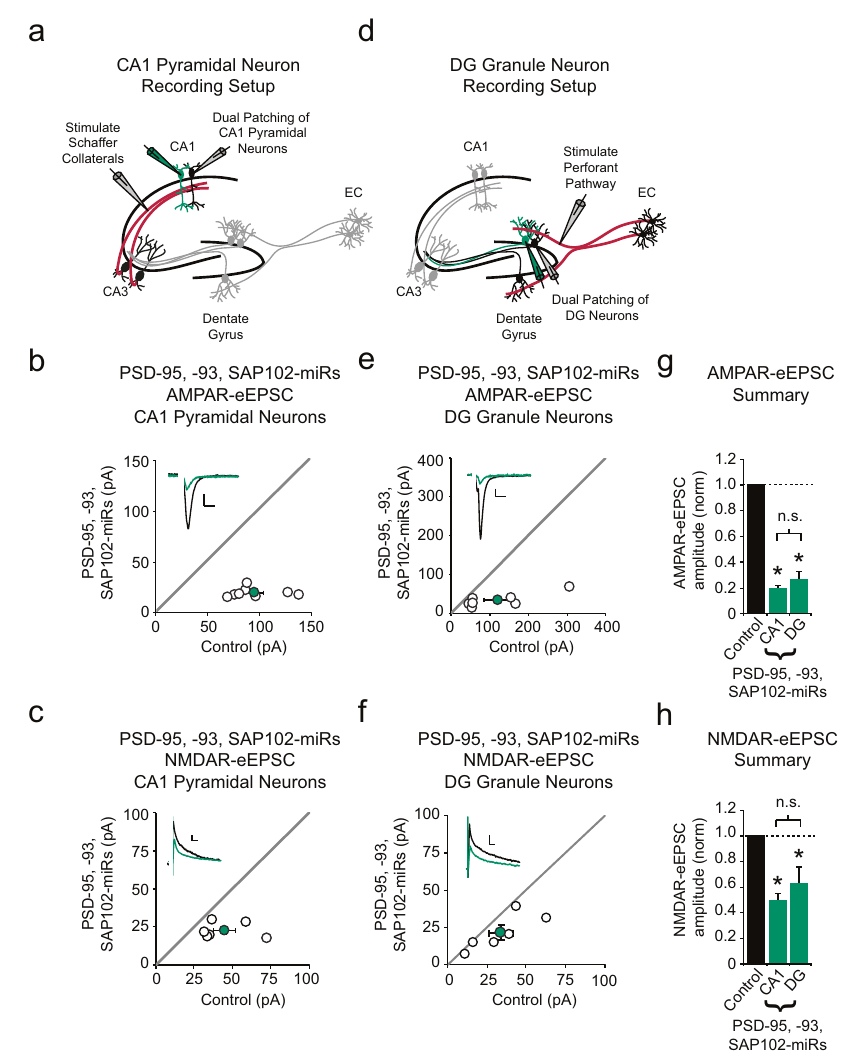
Fig. 3 PSD-95, PSD-93, SAP102 knockdown similarly affects CA1 pyramidal neurons and DG granule neurons. a Schematic representation of electrophysiological recording setup for CA1 pyramidal neurons. For panels ( b ), ( c ), ( e ), and ( f ), open circles are single pairs of control and transfected neurons, fi lled circles represent the mean amplitudes (±SEM), insets show representative current traces from control (black) and transfected (green) neurons with stimulation artifacts removed. Scale bars: 20 ms for AMPA, 50 ms for NMDA, 20 pA. b PSD-95, PSD-93, and SAP102 knockdown signi fi cantly decreases AMPAR-eEPSC amplitude in CA1 pyramidal neurons ( n = 8 pairs, p = 0.00006, paired T test). c PSD-95, PSD-93, and SAP102 knockdown signi fi cantly decreases NMDAR-eEPSC amplitude in CA1 pyramidal neurons ( n = 6 pairs, p = 0.03, paired T test). d Schematic representation of electrophysiological recording setup for DG granule neurons. e PSD-95, PSD-93, and SAP102 knockdown signi fi cantly decreases AMPAR-eEPSC amplitude in DG granule neurons ( n = 7 pairs, p = 0.03, paired T test). f PSD-95, PSD-93, and SAP102 knockdown signi fi cantly decreases NMDAR-eEPSC amplitude in DG granule neurons ( n = 6 pairs, p = 0.045, paired T test). g , h Summary bar graphs show the average AMPAR-eEPSC amplitudes (±SEM) ( g ) and NMDAR-eEPSC amplitudes (±SEM) ( h ) of CA1 pyramidal neurons and DG granule neurons expressing PSD-95, PSD-93, SAP102 miRs (green) normalized to their respective control cell average eEPSC amplitudes (black). Two-sample T tests were used to compare across independent conditions (CA1 vs. DG); (CA1 vs. DG (AMPA), n = 8 CA1 pairs, 7 DG pairs, p = 0.12; CA1 vs. DG (NMDA), n = 6 CA1 pairs, 6 DG pairs, p = 0.34). * p < 0.05; n.s., not signi fi cant. All statistical tests performed were two-tailed. Source data are provided in the Source Data fi